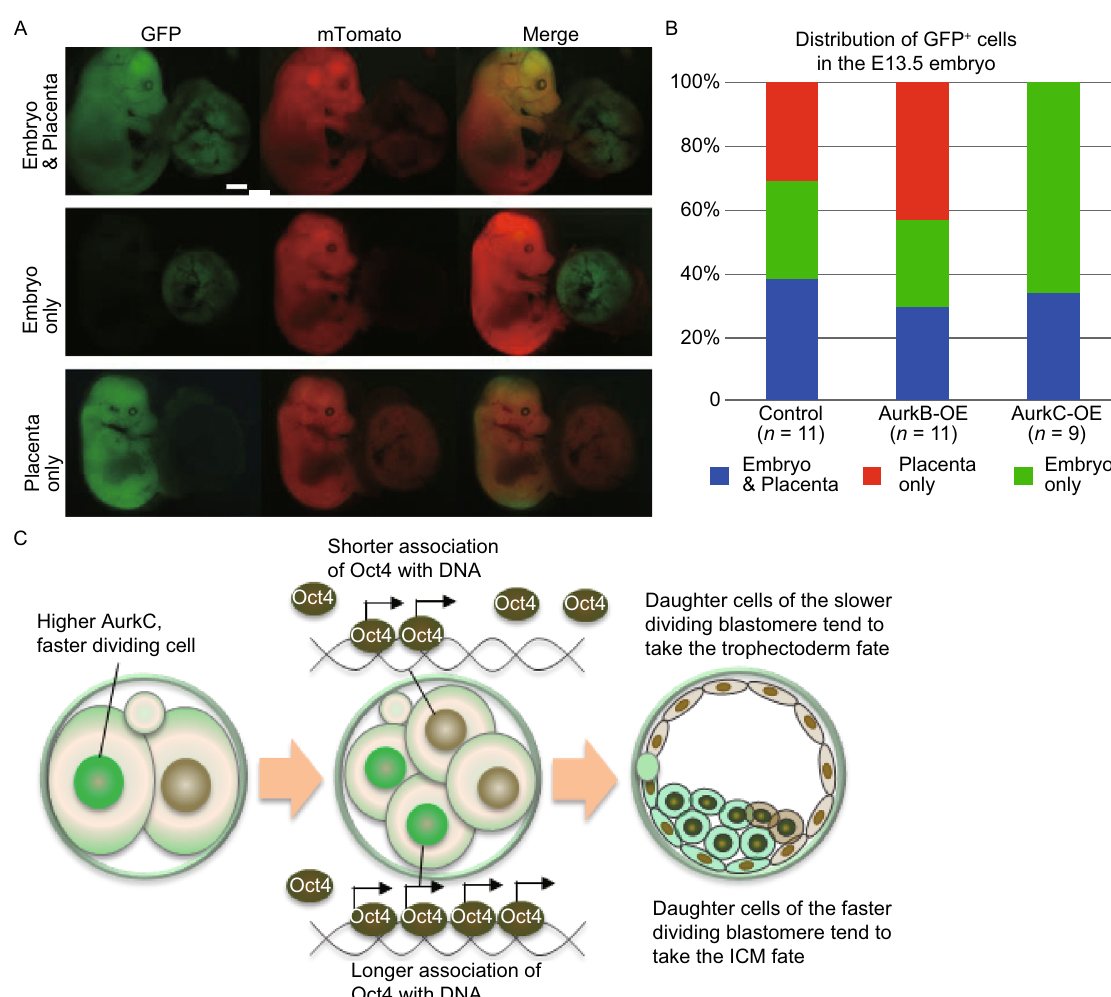
Figure 5. Long term effect of AurkB and AurkC overexpression during preimplantation embryo development. (A) Images of GFP positive cells in E13.5 Rosa embryos and placenta. The distribution was listed at the side of images. Scale bars, 2 mm. (B) Bar graph quanti fi cation of the percentage of embryo or placenta or both. Control ( n = 11), AurkB-OE ( n = 11), AurkC-OE ( n = 9) groups. (C) Model of how cell division may affect cell fate decision in preimplantation